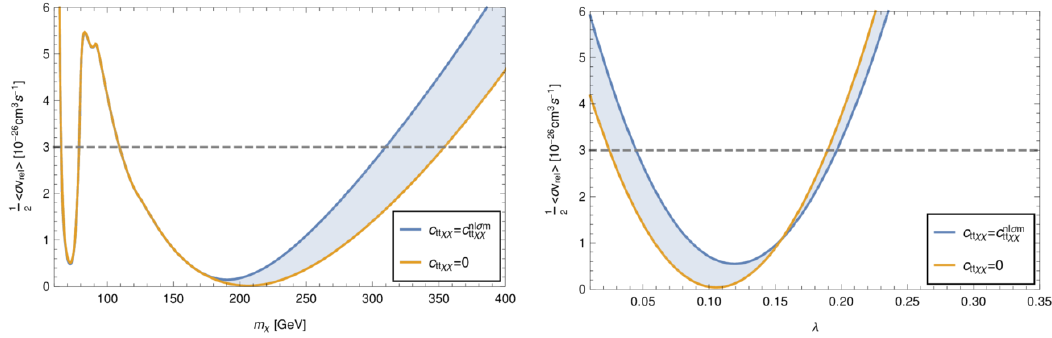
Figure 7 . Impact on the total annihilation cross section of varying the strength of the t (cid:22) t(cid:31) (cid:3) (cid:31) contact interaction in the range c tt(cid:31)(cid:31) 2 [ c nl (cid:27) m ; 0]. The lower value corresponds to the pure sigma model, tt(cid:31)(cid:31) where top partner mixing is neglected, whereas the upper value corresponds to a setup with fully composite t R , where top partner mixing is maximal. The realistic parameter points lie within this range, i.e. they fall within the band shaded in blue. The gray dashed line shows the value required to reproduce the present relic abundance according to the approximate relation in eq. (4.7). In the left panel we set (cid:21) = 0 : 05, whereas in the right panel the DM mass was (cid:12)xed to m (cid:31) = 300 GeV. We took f = 1 : 4 TeV in both